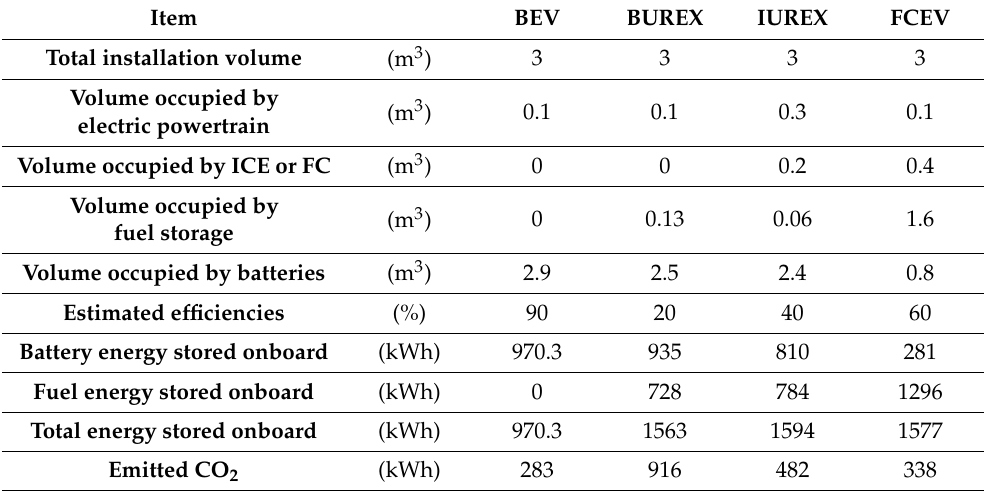
Table 1. Volume occupied by different components of the BEV, BUREX, IUREX, and FC systems.